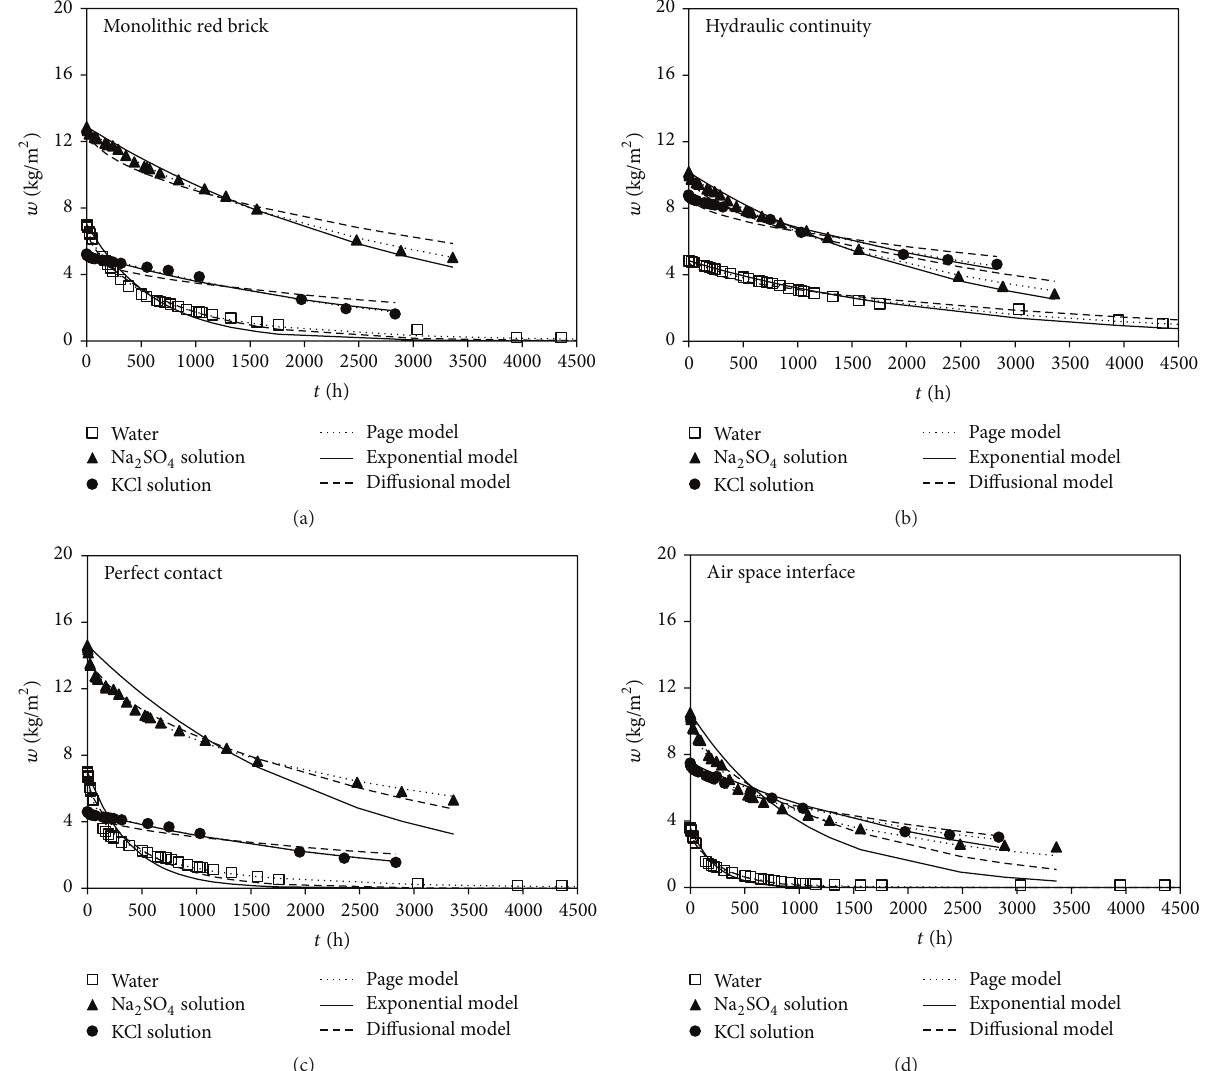
Figure 8: Drying curves of red brick samples with pure water and saturated solutions of KCl and Na 2 SO 4 , for (a) monolithic specimens, (b) hydraulic continuity interface, (c) perfect contact interface, and (d) air space